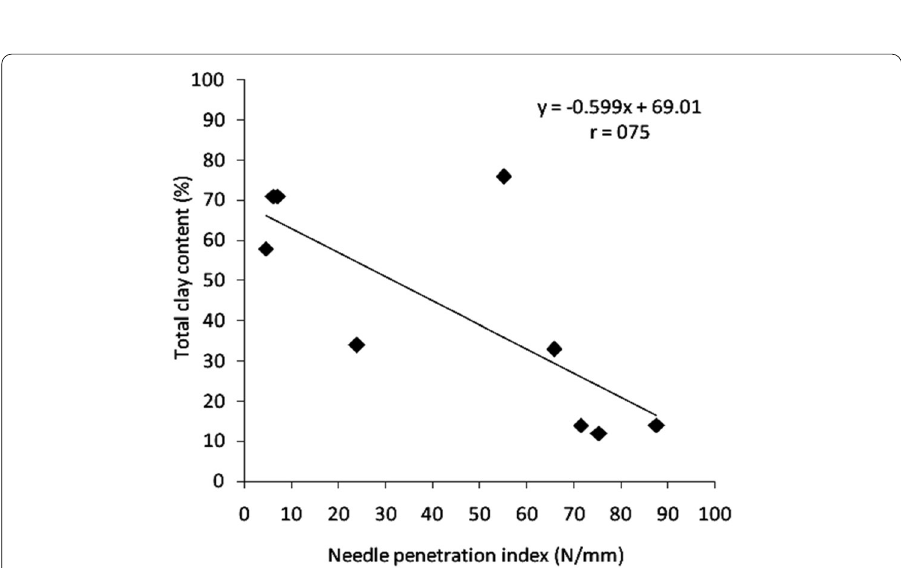
Fig. 7 Correlation between the NPI and the total clay